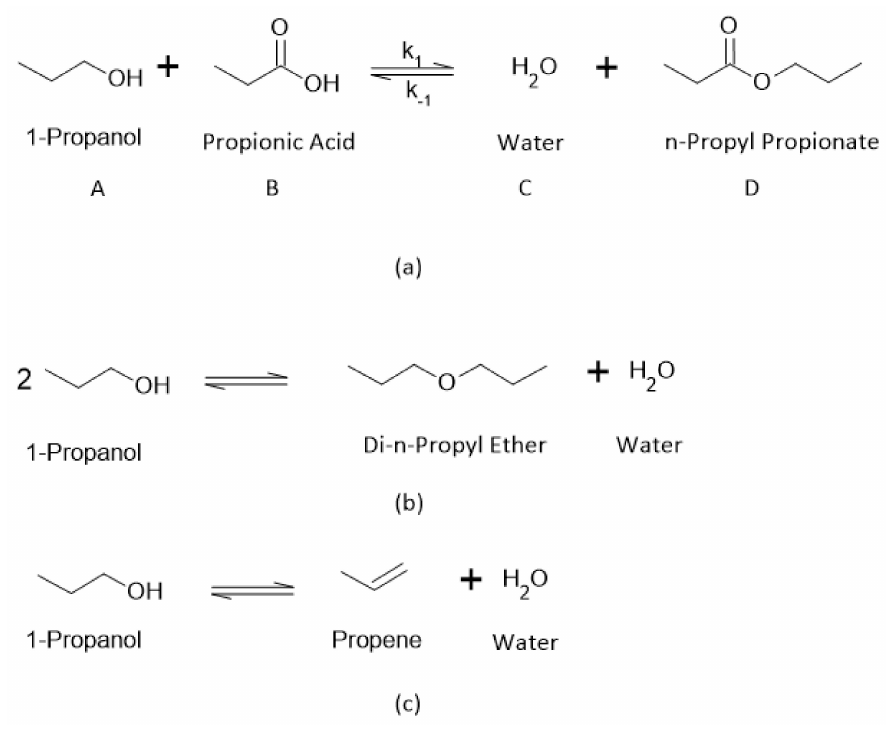
Figure 2. Synthesis of n-Propyl Propionate ( a ) and secondary reactions ( b ) and ( c